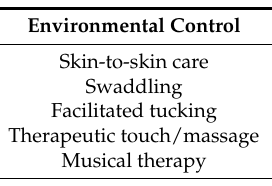
Table 1. Non-pharmacological treatments for pain